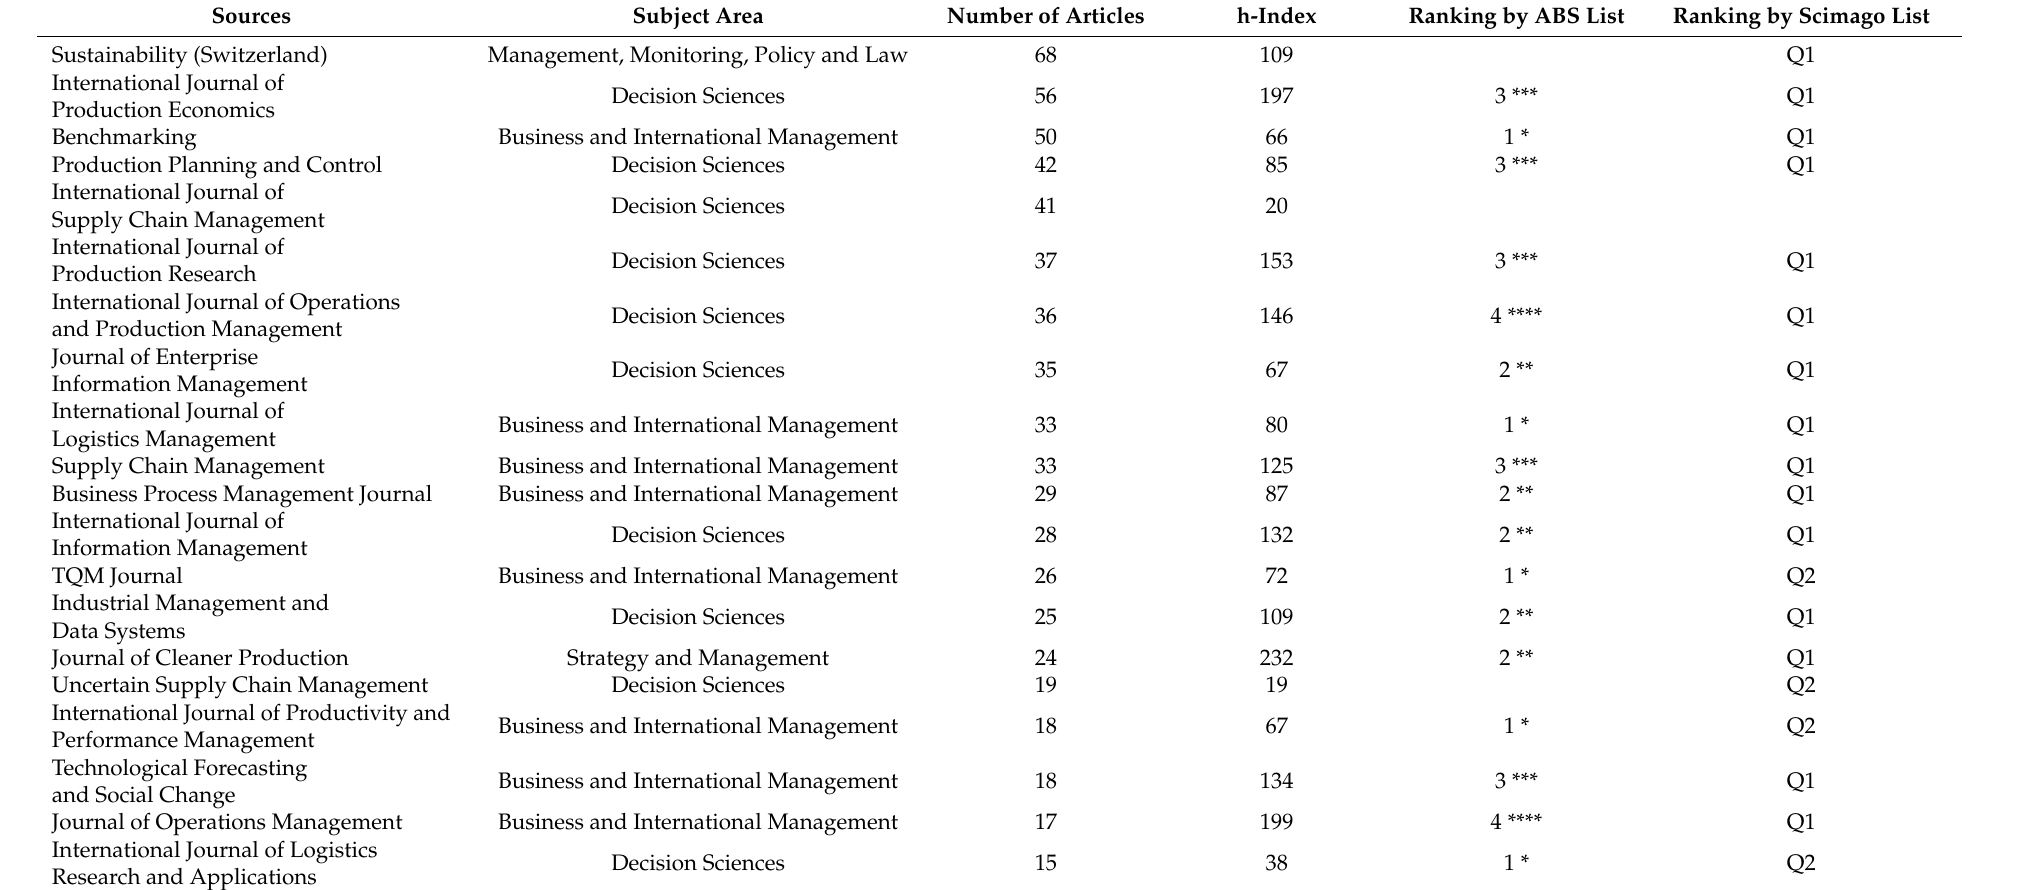
Table 3. Most relevant resources in the research